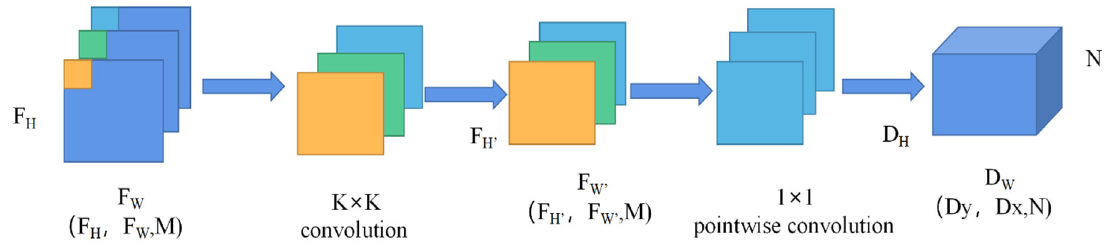
Figure 4. Depthwise separable convolution.